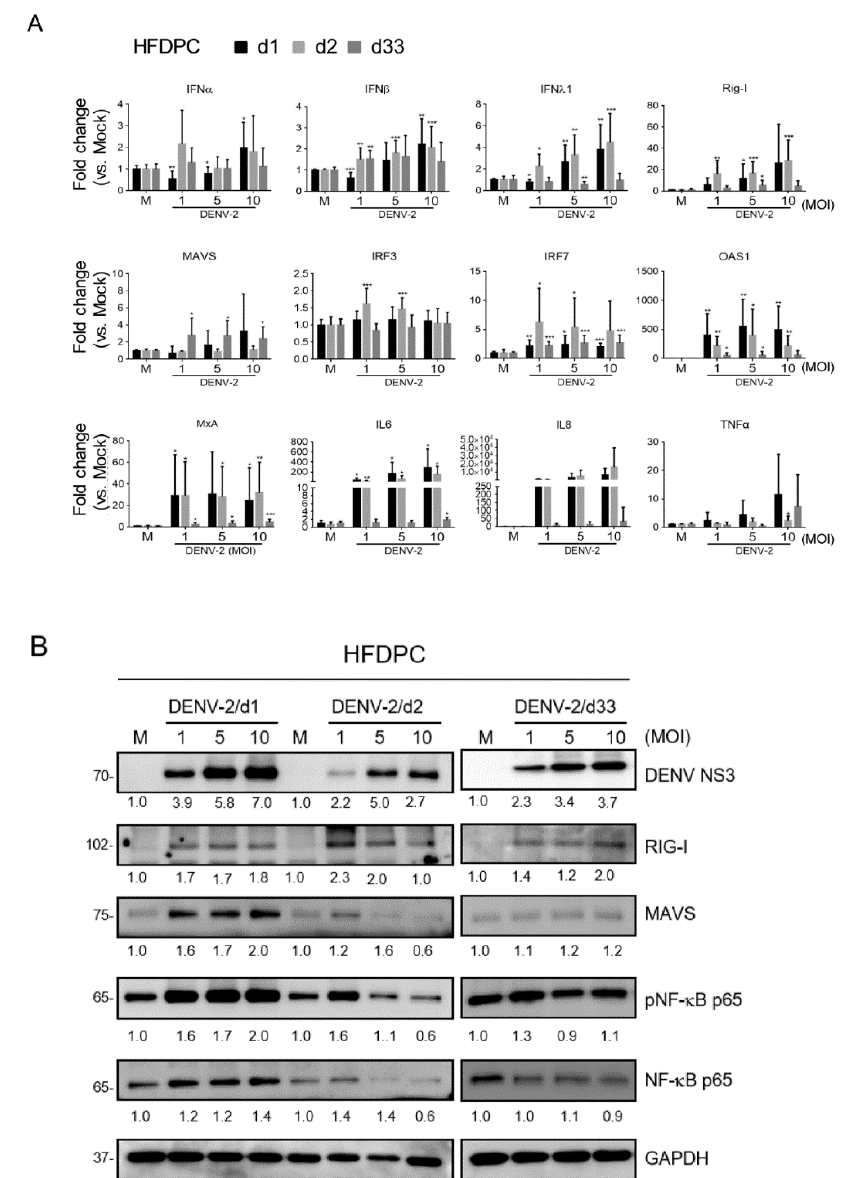
Figure 6. Analysis of the anti ‐ viral inflammation in HFDPCs with acute or long ‐ term DENV ‐ 2 infections. ( A ) qRT ‐ PCR of the indicated mRNA expression in WS1 cells infected with DENV ‐ 2 at MOI 1, 5, and 10 for 1, 2, and 33 days. The gene expression was normalized to Gapdh . Data are presented as mean ± SD from three independent tests, * p < 0.05, ** p < 0.01, *** p < 0.005 vs. mock control. (B) The DENV ‐ 2 ‐ infected HFDPCs lysates were subjected to SDS ‐ PAGE and Western blot analysis. Representative data were obtained from three independent tests. Quantification of each protein level at days 1, 2, and 33 days with GAPDH was normalized to individual mock control.